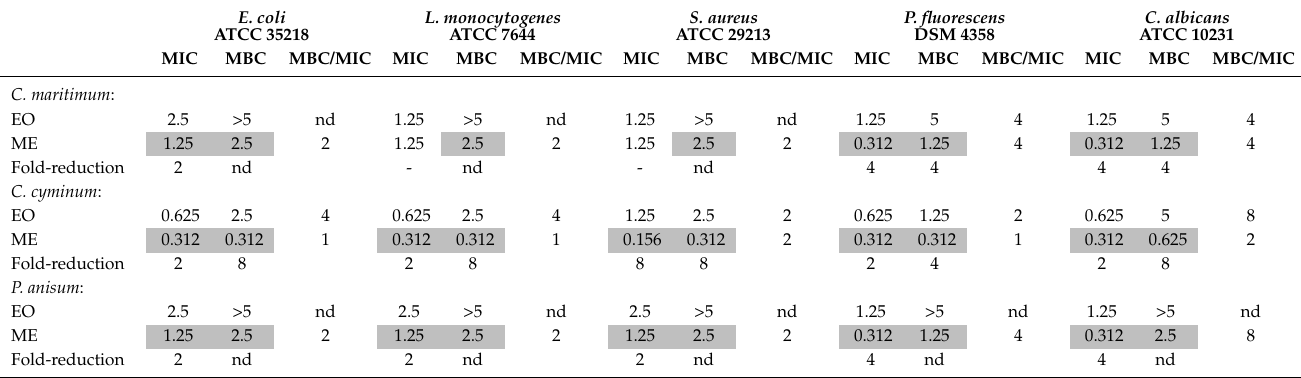
Table 3. Comparative MIC and MBC values (%, v / v ) of the EOs and related MEs against foodborne pathogens and spoilage microorganisms. MIC and MBC values of EO-MEs lower than those of the related EOs are highlighted in grey. Fold-reduction of MIC and MBC values of each EO in the formulated ME as well as the related MBC/MIC ratio are